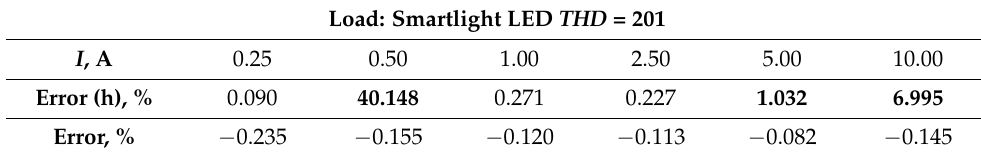
Table 9. Dependence of the electronic energy meter errors on the current value for THD =